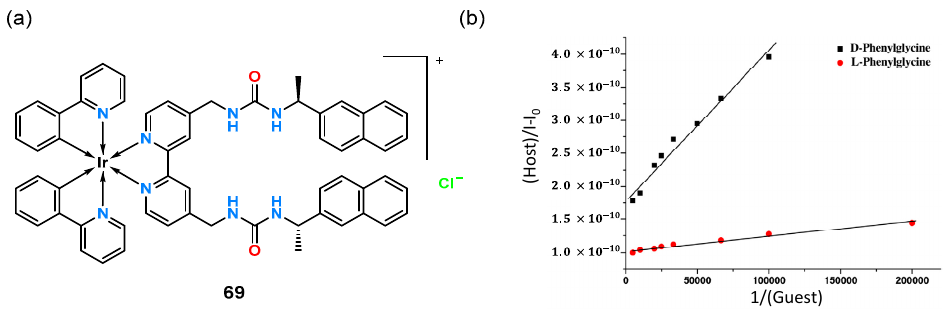
Figure 23. ( a ) Diurea receptor 69 containing iridium complex and ( b ) linear dependence of the phosphorescence intensity to the inverse of the guest concentration.